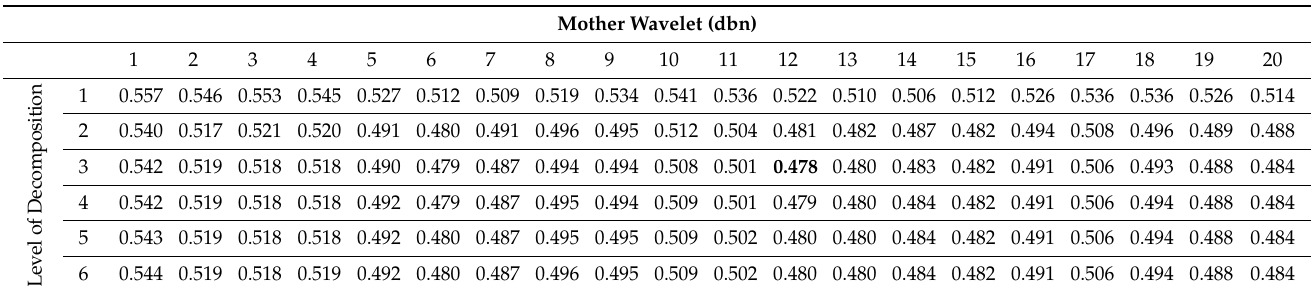
Table 4. Sample Selection of level of decomposition and mother wavelet based on minimum RMSE value. The chosen value is highlighted in bold.